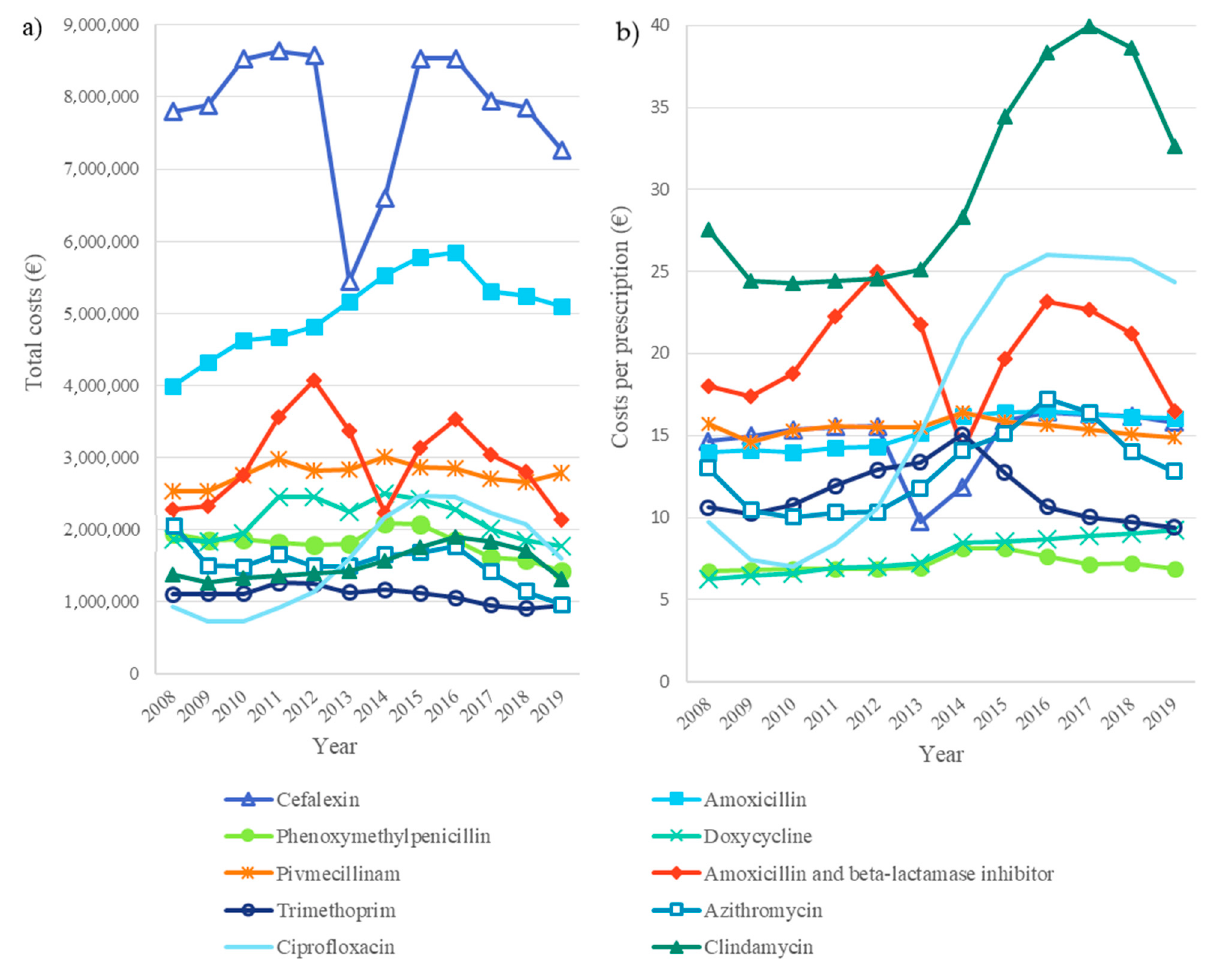
Figure 5. Trends of antibiotic costs for the 10 most frequently used antibiotics in Finland from 2008–2019. ( a ) Total costs. ( b ) Costs per prescription.